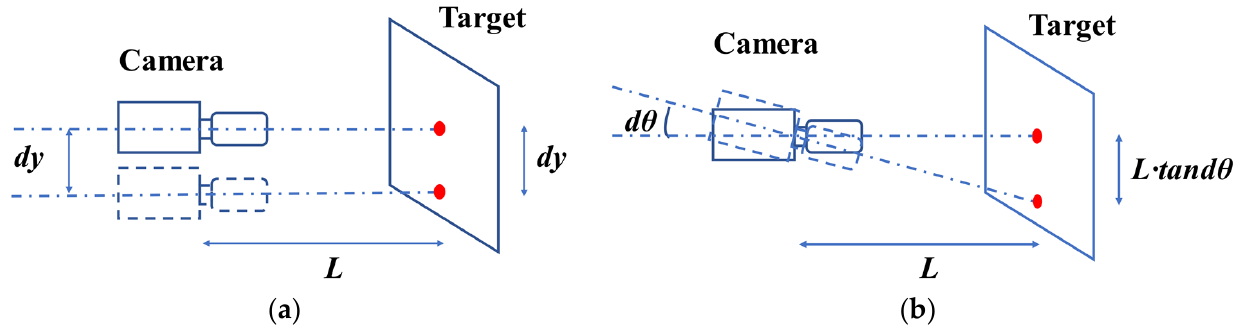
Figure 5. Analysis of error due to camera motion: ( a ) camera translation; and ( b ) camera rotation.